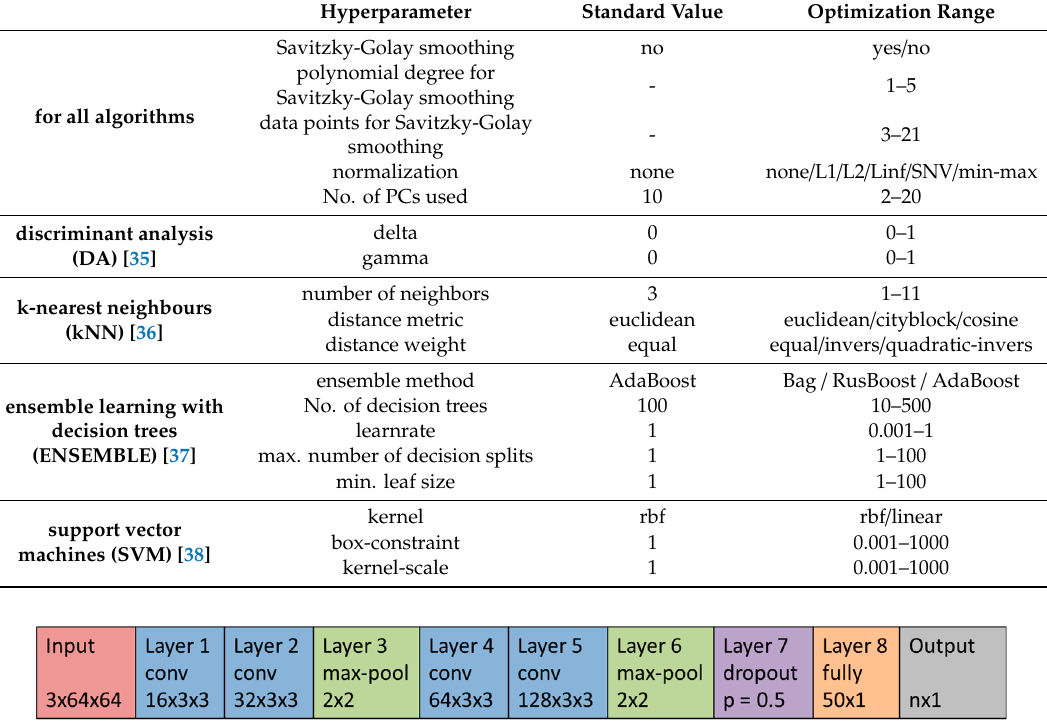
Figure A1. Schematic representation of a sample CNN. The CNN has two convolution blocks with two convolution layers per block. The kernel size of the convolution layer is 3 × 3. The CNN uses max-pooling with a pooling size of 2 × 2. After the last pooling layer is a dropout layer with a dropout probability of 50%. There is one fully connected layer with 50 neurons. The reLu-Layers are not shown in this image. Table A3. Overview of the plastic mixtures considered for the classification tests.